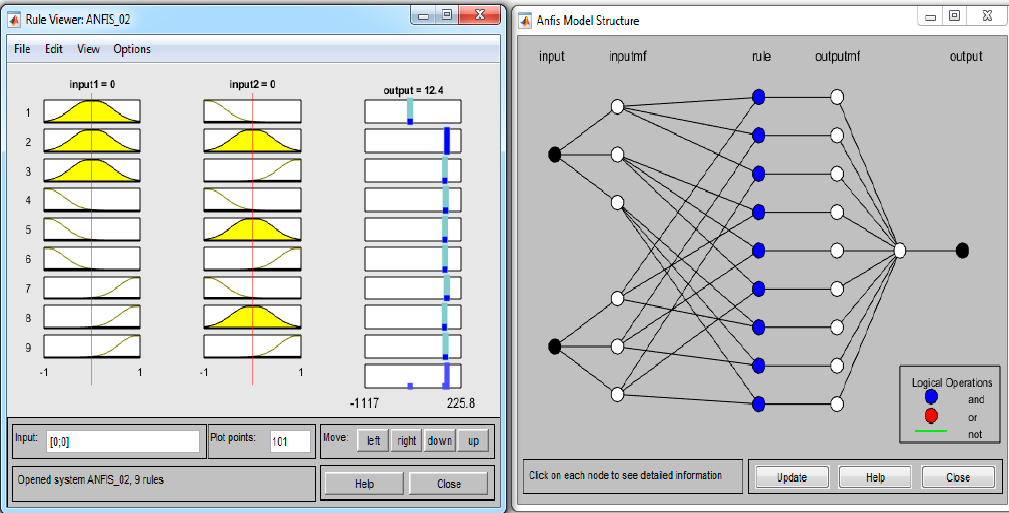
Figure 6. Gaussian built-in membership functions and ANFIS model structure with two inputs and one output, showing all five layers in the ANN architecture.